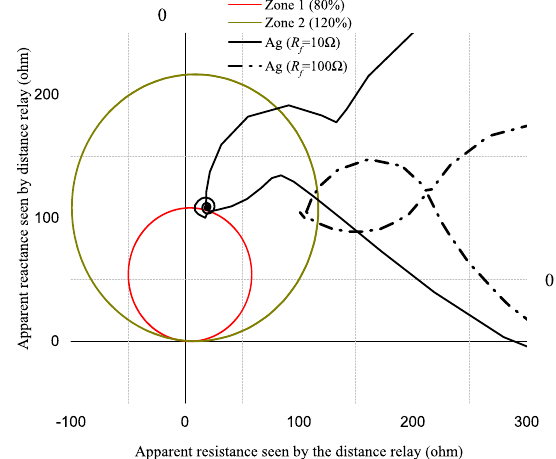
Fig. 4 Mho trajectory during Ag fault occurred with fault resistance 10 Ω and 100 Ω